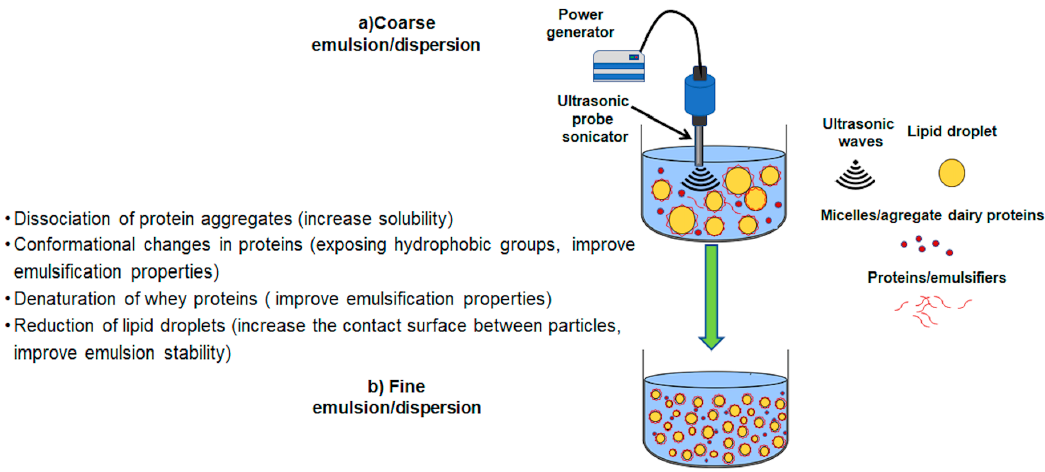
Figure 14. Schematic representation of ultrasonic homogenization. ( a ). Coarse emulsion/dispersion. ( b ). Fine emulsion/dispersion. ( b ). Fine emulsion /